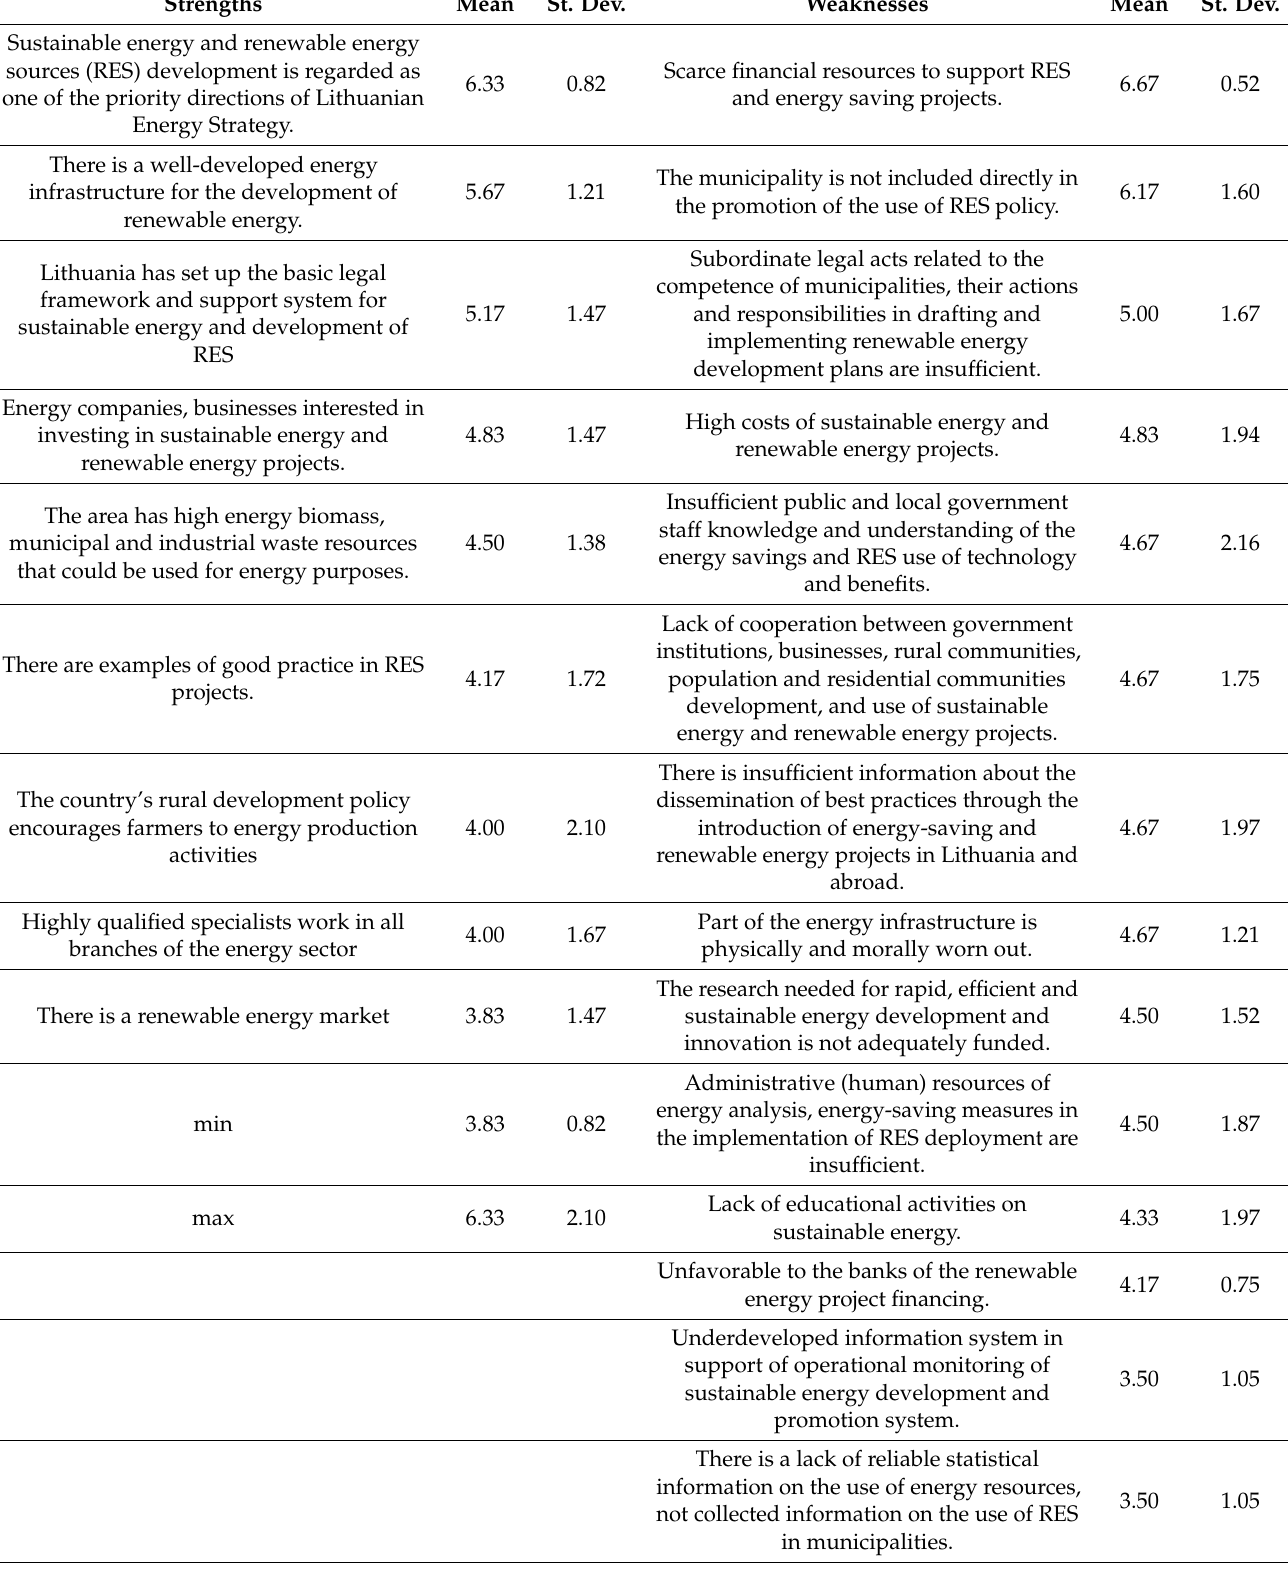
Table 4. Importance of the strengths and weaknesses of RES development in